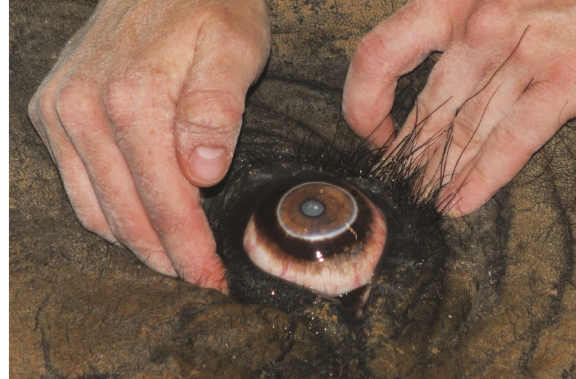
Figure 7: Manual digital pressure was applied simultaneously to the upper and lower eyelids to displace the globe anteriorly, thereby providing better access to the sites of injection for the modified retrobulbar block described and shown in Figure 6.